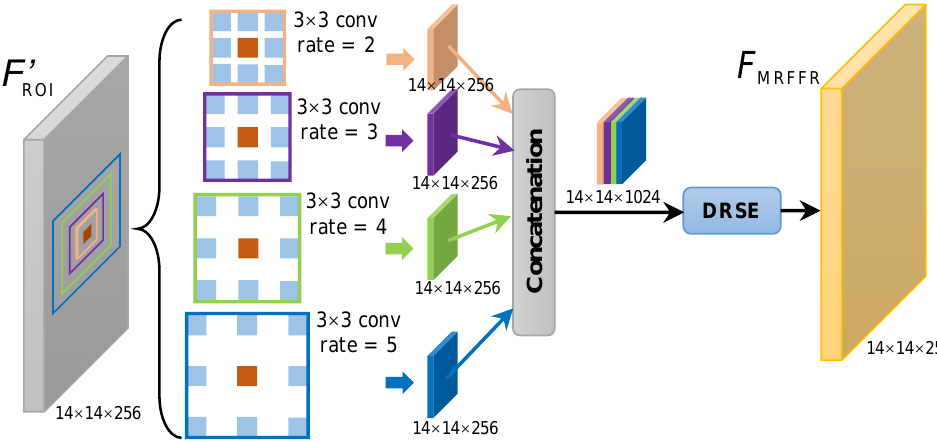
Figure 6. Implementation of the multi receptive-field feature response (MRFFR) in GCIM-Block. DRSE denotes the dimension reduction squeeze-and-excitation.